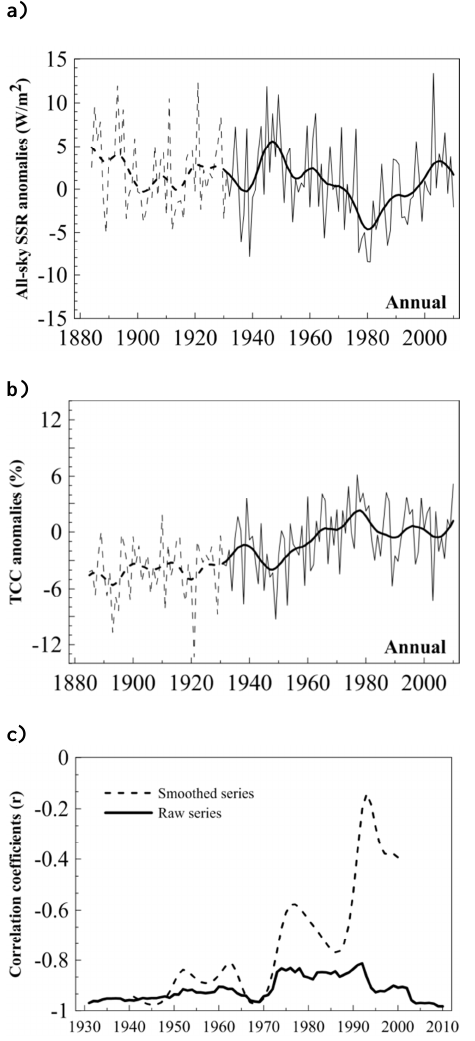
Fig. 3. Mean annual all-sky SSR (a) and TCC (b) series (thin line) from 1885 to 2010 for all 17 stations in Switzerland, plotted to- gether with the 17-yr Gaussian low-pass filter (thick line). The se- ries are expressed as anomalies from the 1981–2010 mean. Dashed lines are used before 1931 due to the lower confidence in this pe- riod. (c) Annual running correlations with time windows of 21 yr between the raw and smoothed time series using a 17-yr Gaussian low-pass filter during the most confident 1931–2010 period.